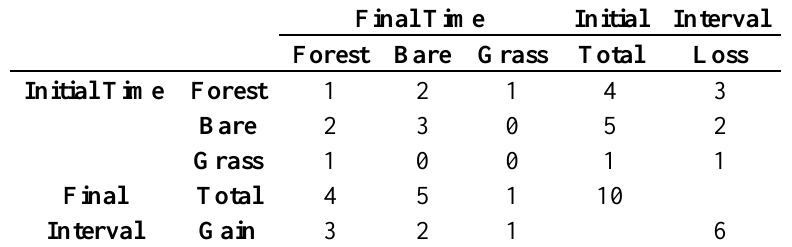
Table 5. Matrix that shows Forest’s gain avoids Bare and Bare avoids Forest’s loss.